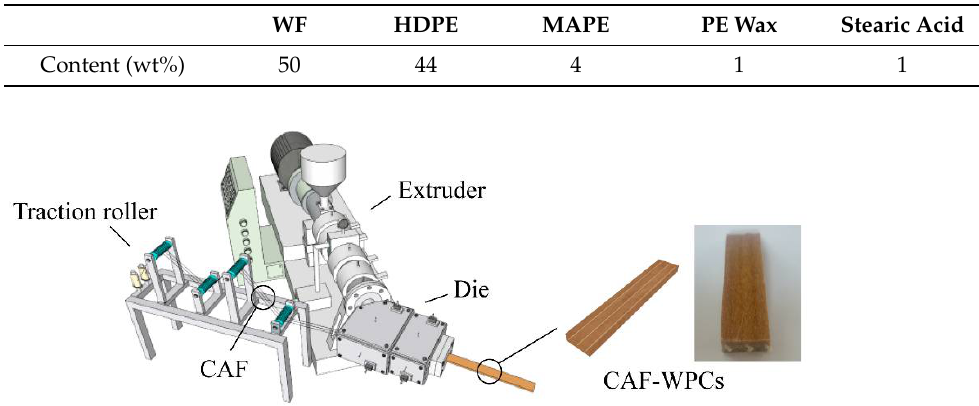
Table 1. Formulation of the composites for extrusion.